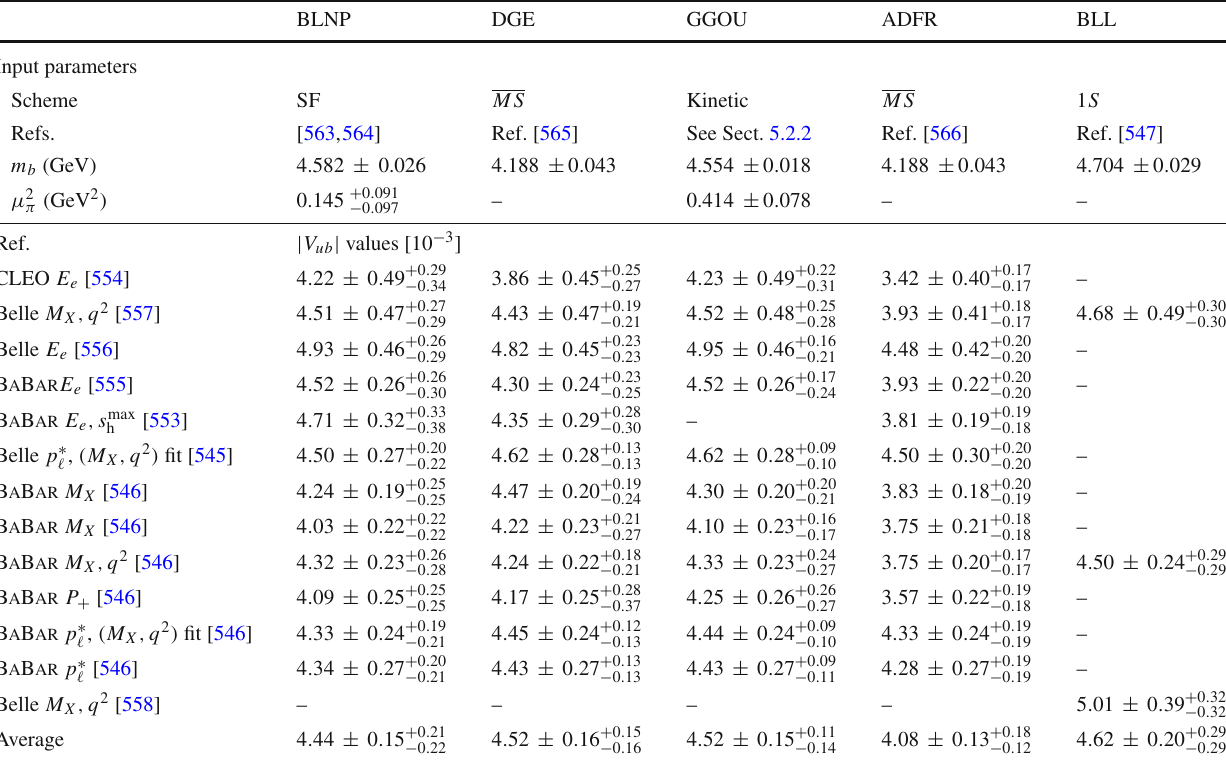
Table 90 Summary of input parameters used by the different theory calculations, corresponding inclusive determinations of | V ub | and their average. The errors quoted on | V ub | correspond to experimental and theoretical uncertainties, respectively BLNP DGE GGOU ADFR